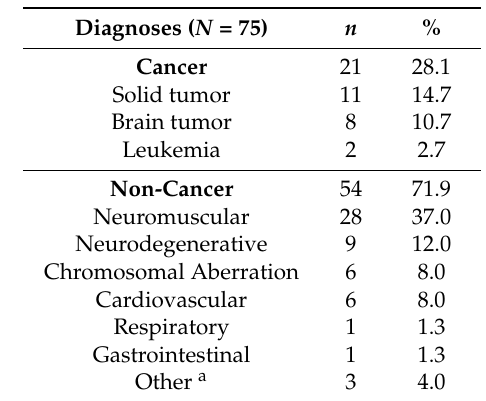
Table 1. Diagnoses of patients in the